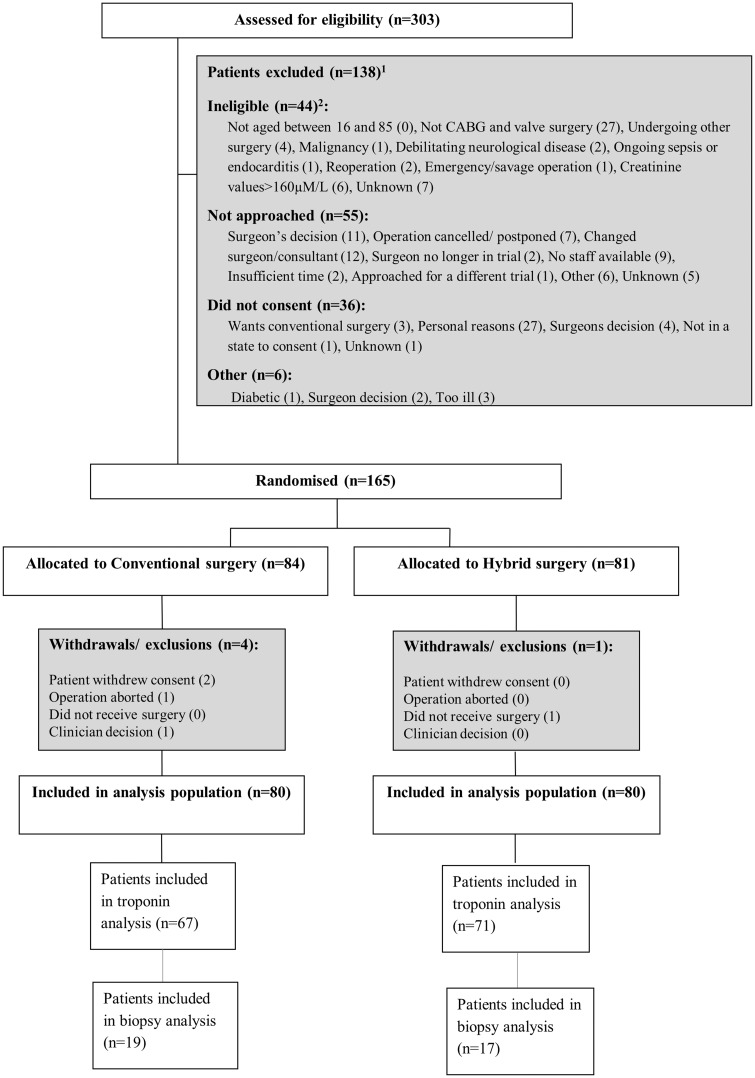
Flow of participants through the trial. Notes: 1Reasons for exclusion are only available for the Bristol site. 2Some patients were ineligible for more than one reason.